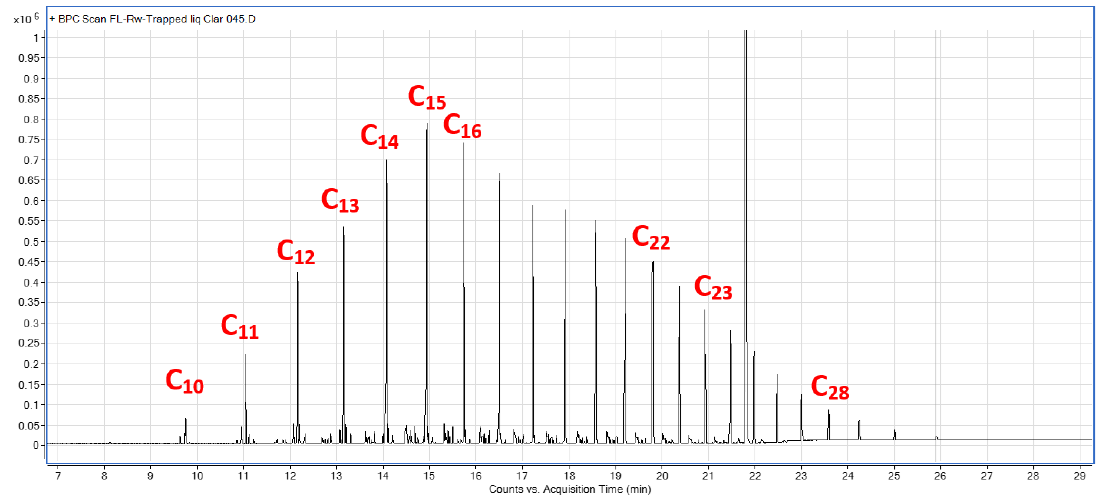
Figure A7. Trapped liquid chromatogram analysis for R3.